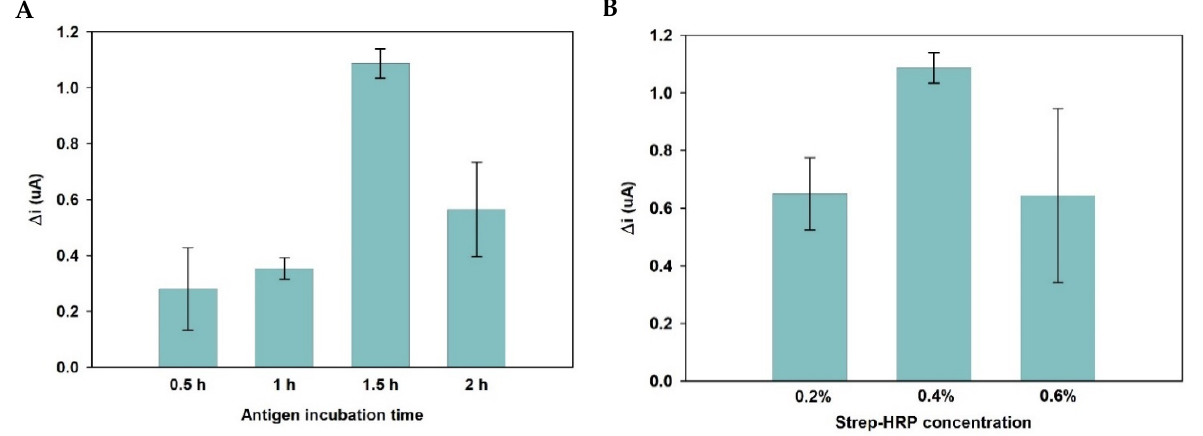
Figure A7. The results of the optimization studies. The incubation time for the optimizing antigen (ds-MGMT) ( A ) and the Streptavidin-HRP concentration ( B ).